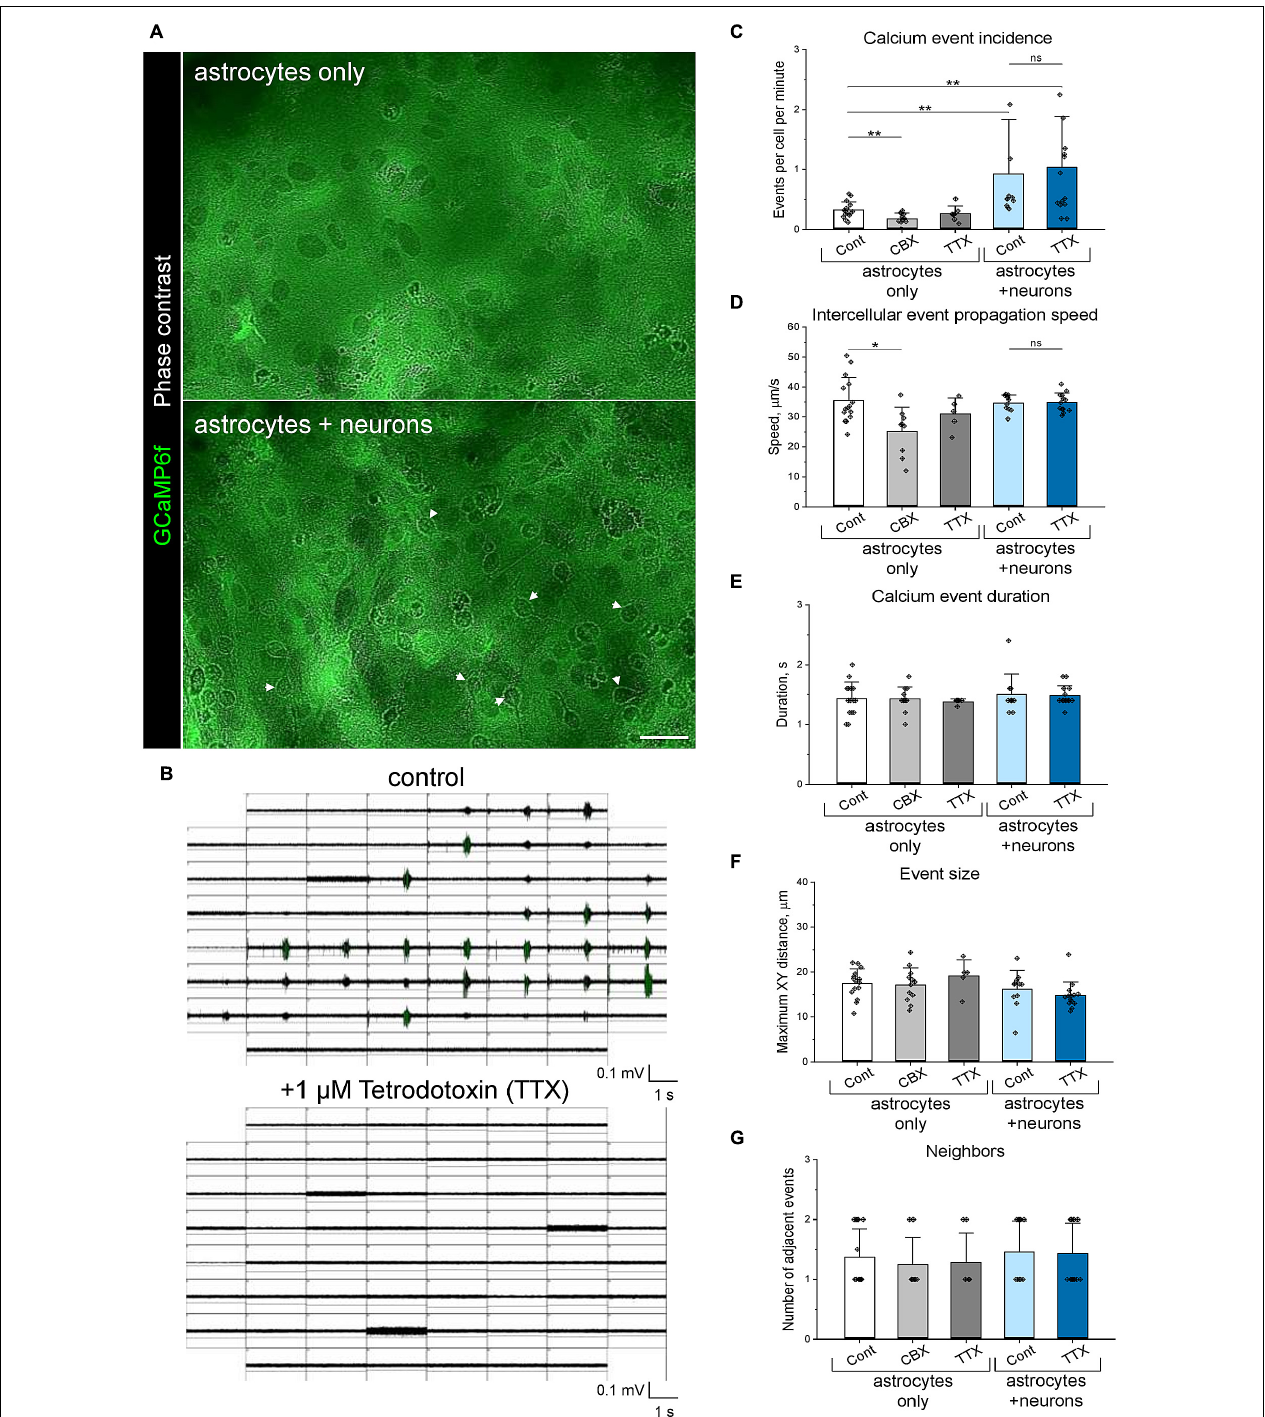
FIGURE 5 | Co-cultivation of primary astrocytes and neurons enhances astrocytic Ca ++ signalling. (A) Live-cell imaging of GCaMP6f expressing astrocytes, which were cultivated with and without neurons. Arrowheads indicate neuronal cell bodies, which can be recognised in phase-contrast images in neuron-astrocyte co-cultures. By preparation, the neurons do not express GCaMP6f. Scale bar, 50 µ m. (B) Neuronal networks exhibit synchronous activity, indicated by network-wide bursts detected using multiple electrode array (MEA) electrophysiology. Application of 1 µ M TTX for 30 min completely silenced neuronal activity. Panels show neuronal activity simultaneously recorded by 59 electrodes (200 µ m centre-to-centre distance), each window representing a single electrode. Neuronal activity was measured independently of calcium imaging. (C–G) Calcium oscillations in astrocytic networks were analysed using the Astral software, measuring calcium wave incidence (C) , median intercellular propagation speed (D) , duration (E) , distance travelled (F) and number of neighbouring waves (G) . Bars show mean ± SD, diamonds are data points indicating median values for the recorded area. ** p < 0.01, * p < 0.05, based on Mann-Whitney tests. n = 5.